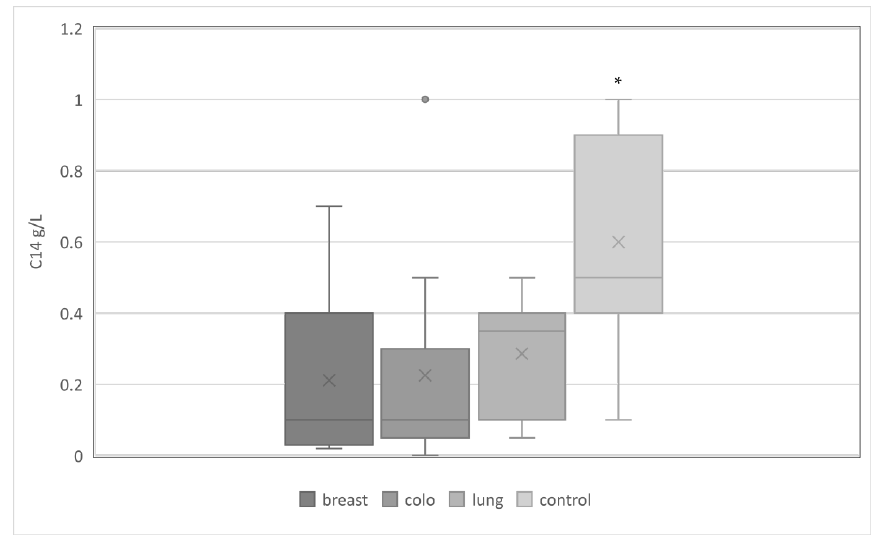
Figure 3. The serum concentrations of C4 in studied groups with C1-INH-AAE. Legend: breast — breast cancer; colo — colorectal cancer; lung — lung cancer; * — significantly higher average concentration of C4 in control groups, p < 0.05.